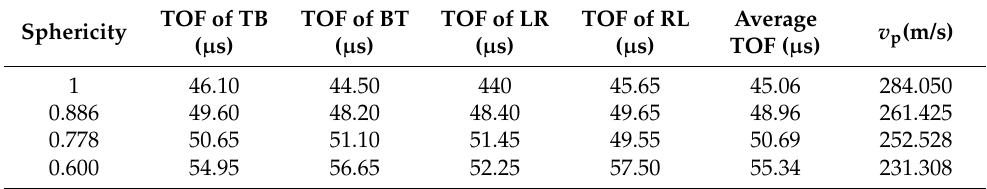
Table 5. Influence of pore sphericity on compression wave velocity.